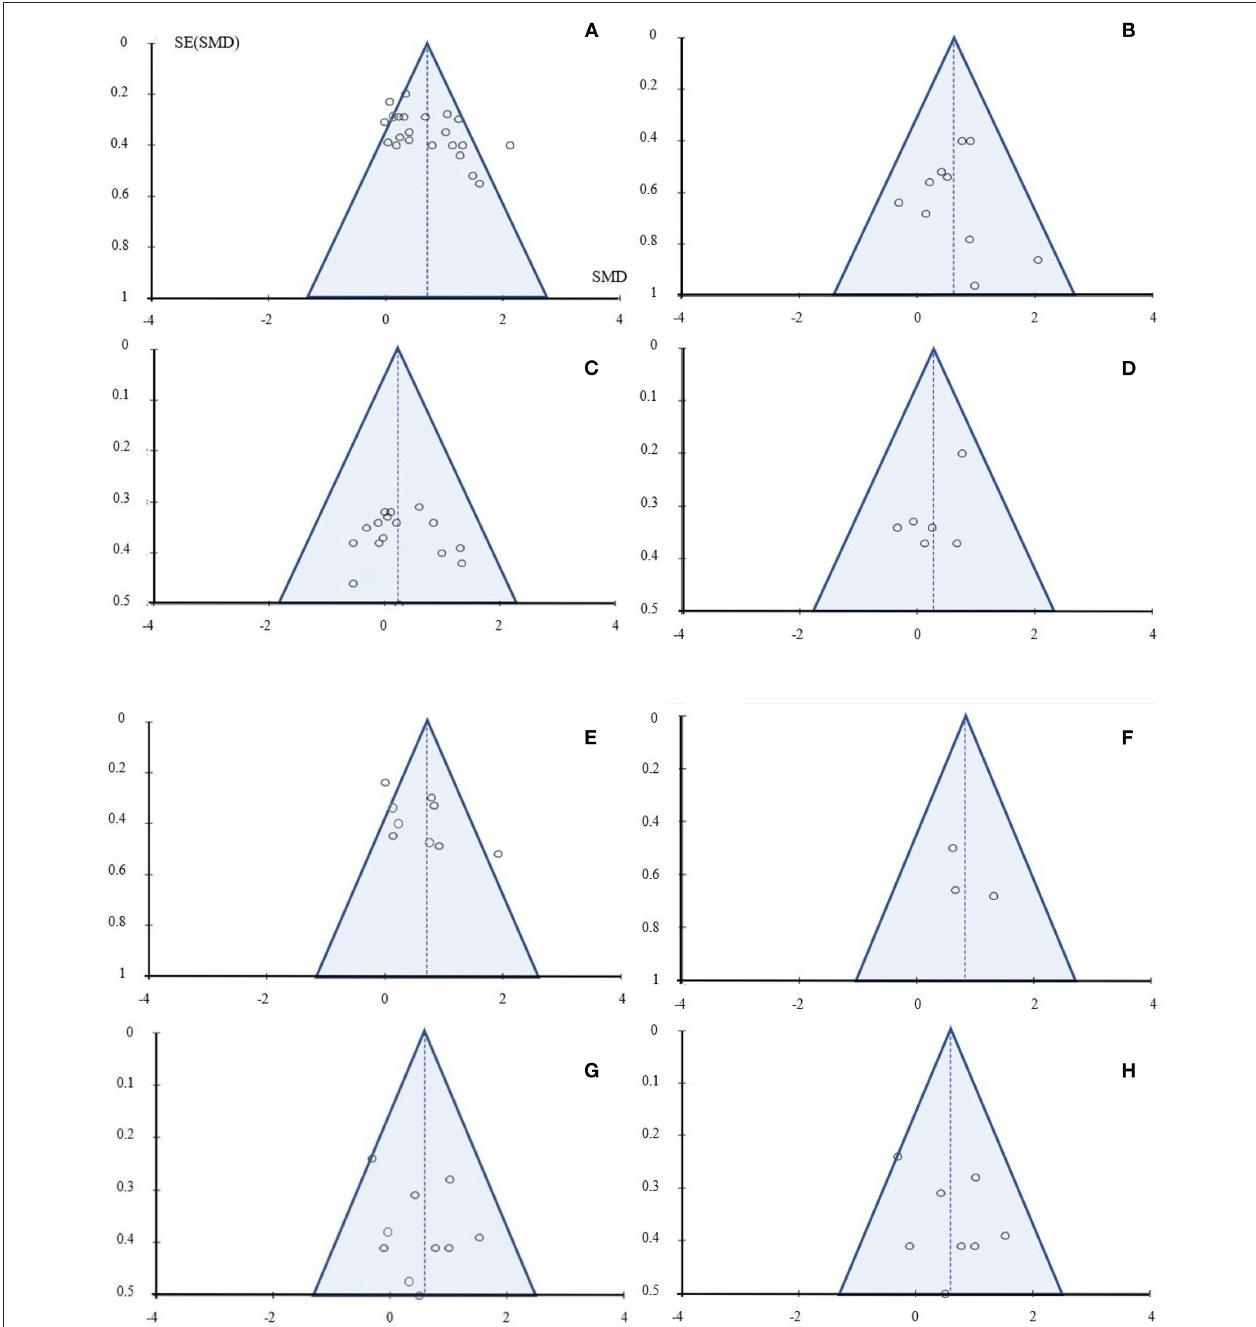
FIGURE 2 | Funnel plot: (A) non-clinical condition - physiological health parameters: Pilates vs. IC; (B) non-clinical condition - psychological health parameters: Pilates vs. IC; (C) non-clinical condition - physiological health parameters: Pilates vs. AC; (D) non-clinical condition - psychological health parameters: Pilates vs. AC; (E) clinical condition - physiological health parameters: Pilates vs. IC; (F) clinical condition - psychological health parameters: Pilates vs. IC; (G) clinical condition - physiological health parameters: Pilates vs. AC; (H) clinical condition - psychological health parameters: Pilates vs. AC.